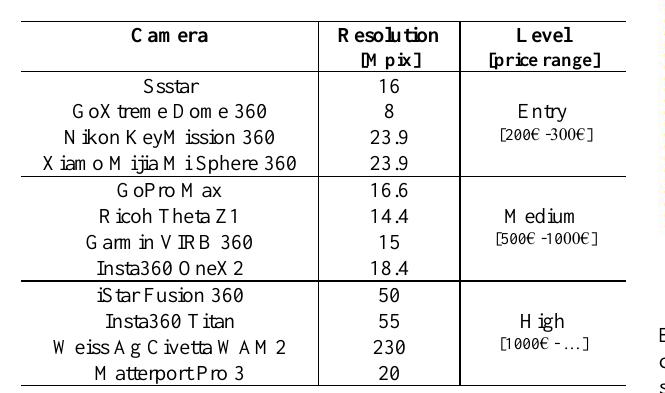
Table 1 . Classification of some commercial 360° cameras.